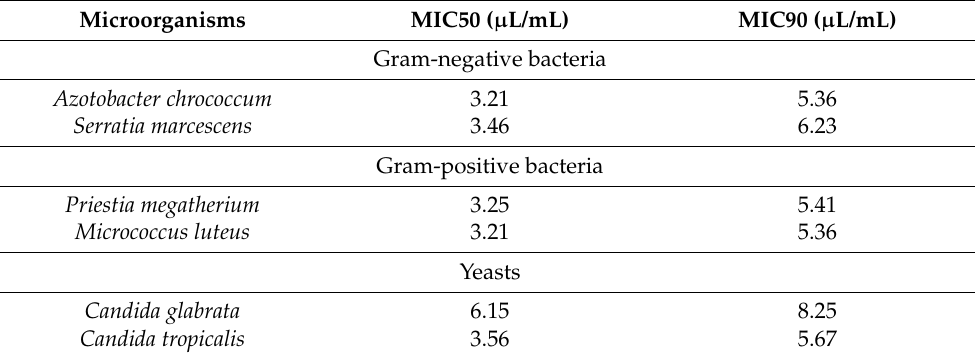
for yeast). Table 3. Minimal inhibition concentration of OBEO.